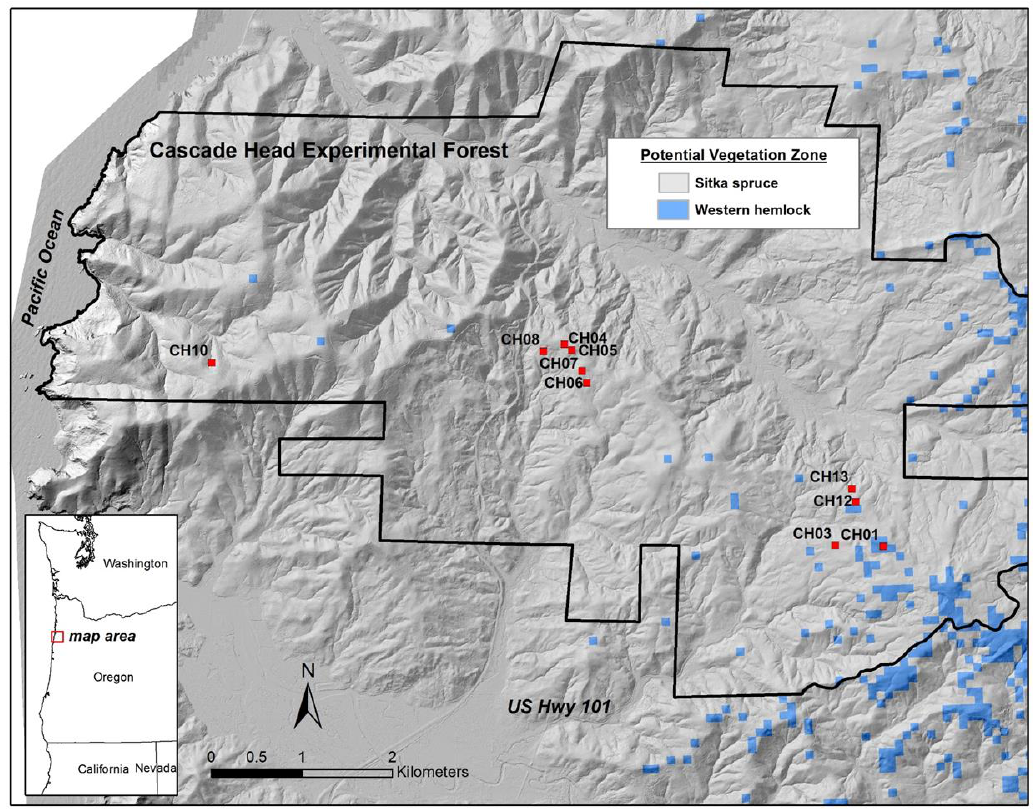
Figure 1. Permanent plot locations in Cascade Head Experimental Forest, Otis, OR, USA, established in 1935 by the US Forest Service.